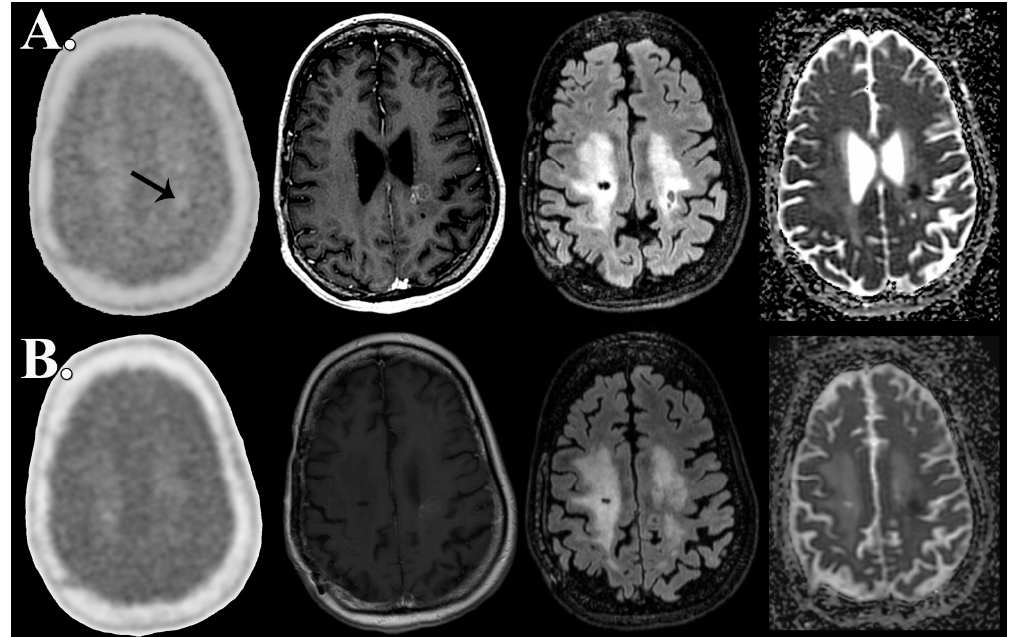
Figure 1. Abseent FMISO hypoxic volume in pseudoprogression prior to and following bevacizumab therapy. FMISO PET/MR imaging obtained simultaneously 7 days prior to ( A ) and 155 days after initiation of antiangiogenesis therapy ( B ) demonstrates pseudoprogression characterized by decreased volume of contrast enhancement (middle left) and nonenhancing FLAIR hyperintense mass (middle right) with associated focus of reduced diffusion (adc map, right). Unprocessed (left) and fused FMISO PET imaging (middle left, middle right, and right) demonstrates absence of FMISO accumulation above 1.2 time background. Pre-therapy FMISO PET/MR demonstrates slightly decreased focus of radiotracer uptake (upper left, arrow) relative to background which slightly increases to background uptake levels following bevacizumab therapy. FMISO HV is not observed at any time point in this patient with pseudoprogression.